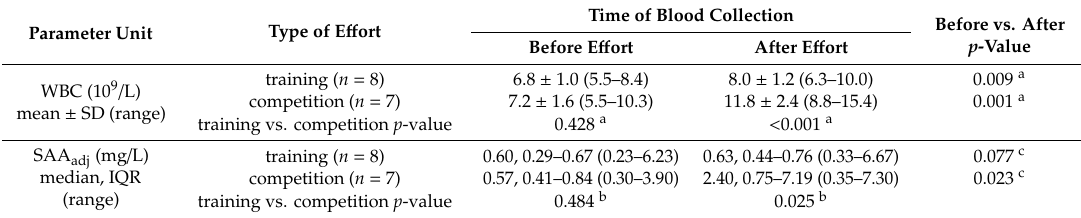
Table 2. WBC and SAA adj before and after the e ff ort (training and competition). Parameter Unit